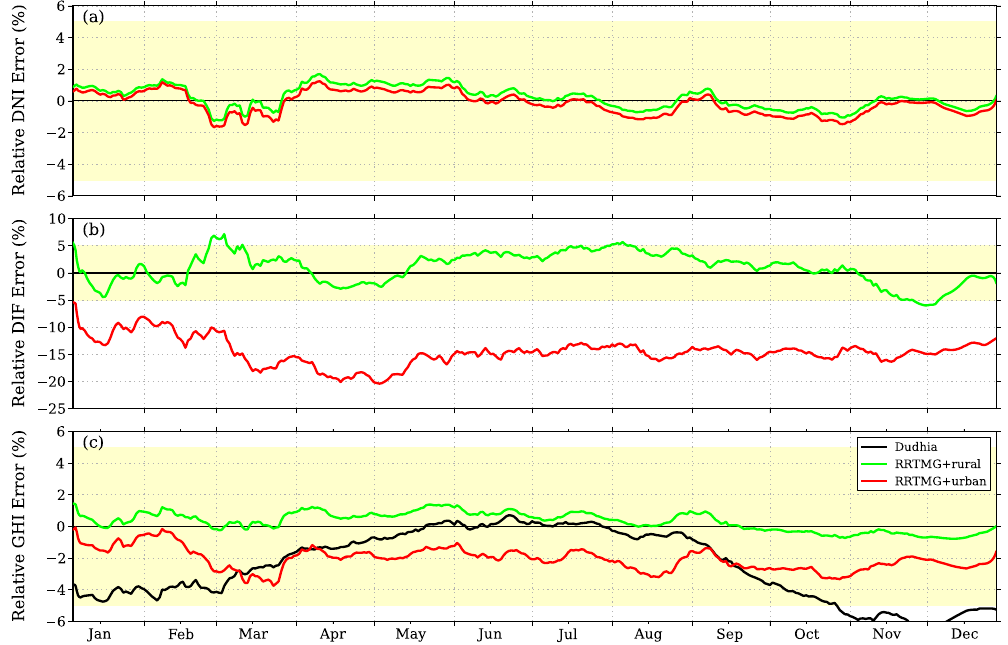
Figure 5. Daily mean relative error in the predicted DNI, DIF and GHI irradiances (simulated values minus observations, relative to the observations) using the RRTMG assuming rural and urban aerosol models throughout the simulated year and the composite of the five experimental sites. A 15-day moving average filter has been used to make clear the bias trend. For GHI, the calculated values with the Dudhia scheme are also shown. The expected observational error region for the surface solar irradiance observations, roughly estimated as ± 5 %, is highlighted in